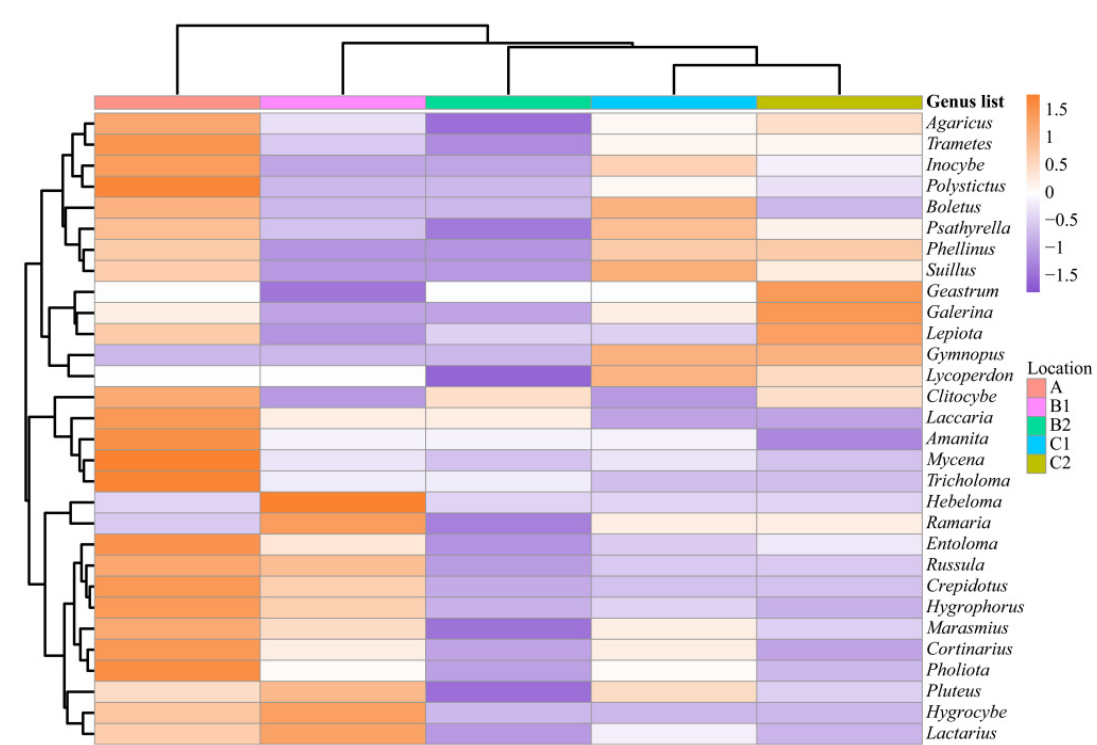
Figure 14. Complex heatmap of the macrofungi composition (genus level) at six investigation sites from Jilin Province. A1: Quanshuidong Forest Farm; A2: Lushuihe National Forest Park; B1: Shengli River Forest Farm; B2: Longwan National Forest Park; C1: Zuojia Region; C2: Jingyuetan National Forest Park.